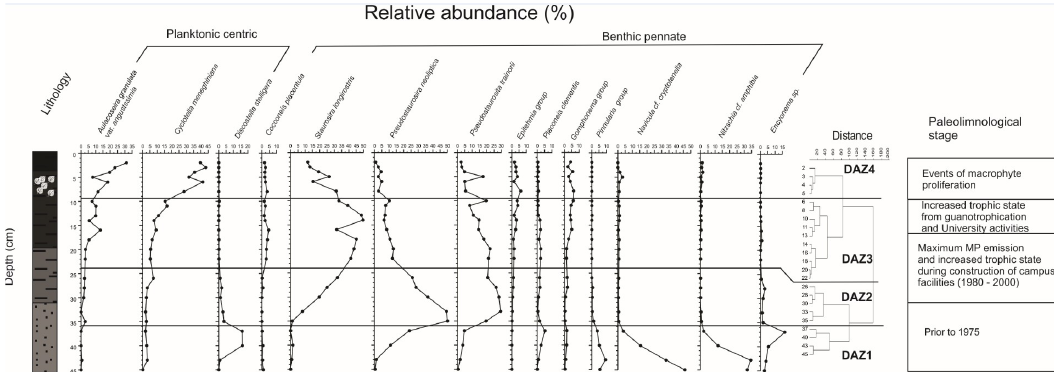
Figure 4. Relative abundances of dominant diatom species. Age and cluster analysis showing the identified diatom association zones (DAZ) are shown to the right of the